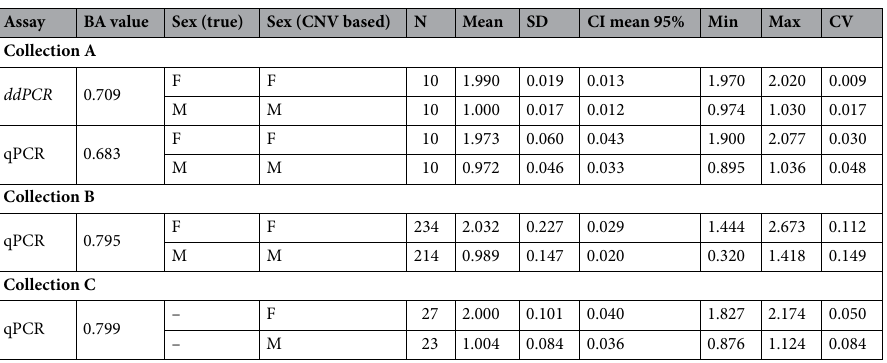
Table 4. Bimodality Amplitude (BA) values and other descriptive statistics of CNV values in all